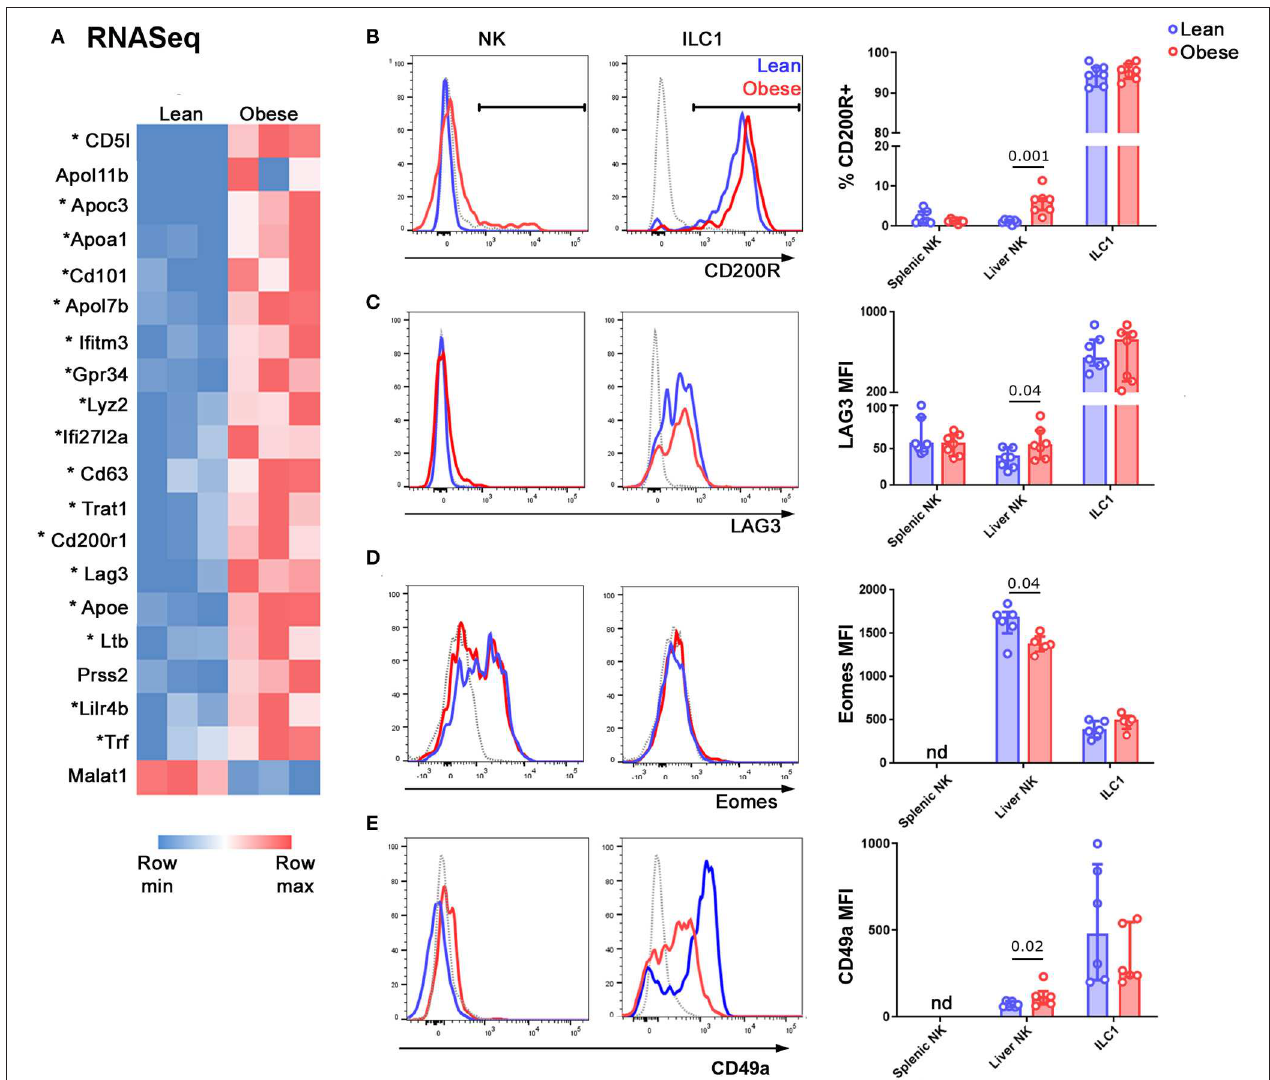
FIGURE 3 | NK cells in the livers of obese mice acquire an ILC1-like transcriptional profile. (A) NK cells and ILC1 were sorted from the livers of lean and obese mice and examined by RNASeq. Genes that were differentially expressed by > 2-fold, with padj < 0.05, in NK cells of lean vs. obese mice are shown. Genes that are also differentially expressed in ILC1 compared to NK ( > 2-fold, with padj < 0.05) are marked with an asterisk. (B,C) Protein expression of the inhibitory receptors CD200R1 (B) and LAG3 (C) in NK cells and ILC1 of lean (blue) compared to obese (red) mice. Gray traces represent FMO controls. (D) Expression of Eomes in NK cells and ILC1 of lean (blue) compared to obese (red) mice. Gray traces represent internal negative controls. (E) Expression of CD49a in Lineage-negative NK1.1 + CD49b + cells (NK) and Lineage-negative NK1.1 + CD49b − cells (ILC1) of lean (blue) compared to obese (red) mice. Gray traces represent FMO controls. n = 6 mice per group; significance was determined using Mann Whitney U -Tests; medians and IQRs are